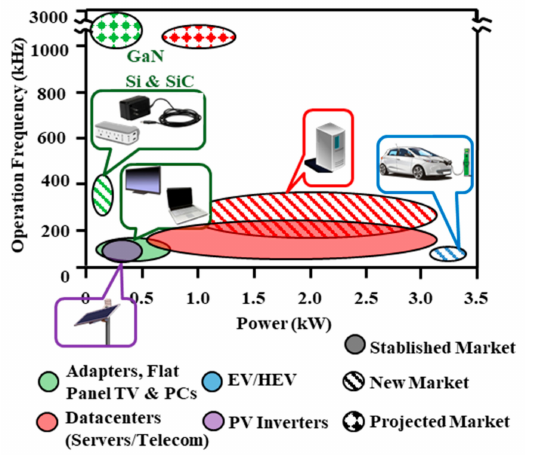
Figure 1. Markets in which resonant converters are used, for di ff erent ranges of frequencies (kHz) and power (kW). EV / HEV, electric and hybrid vehicle; PV,